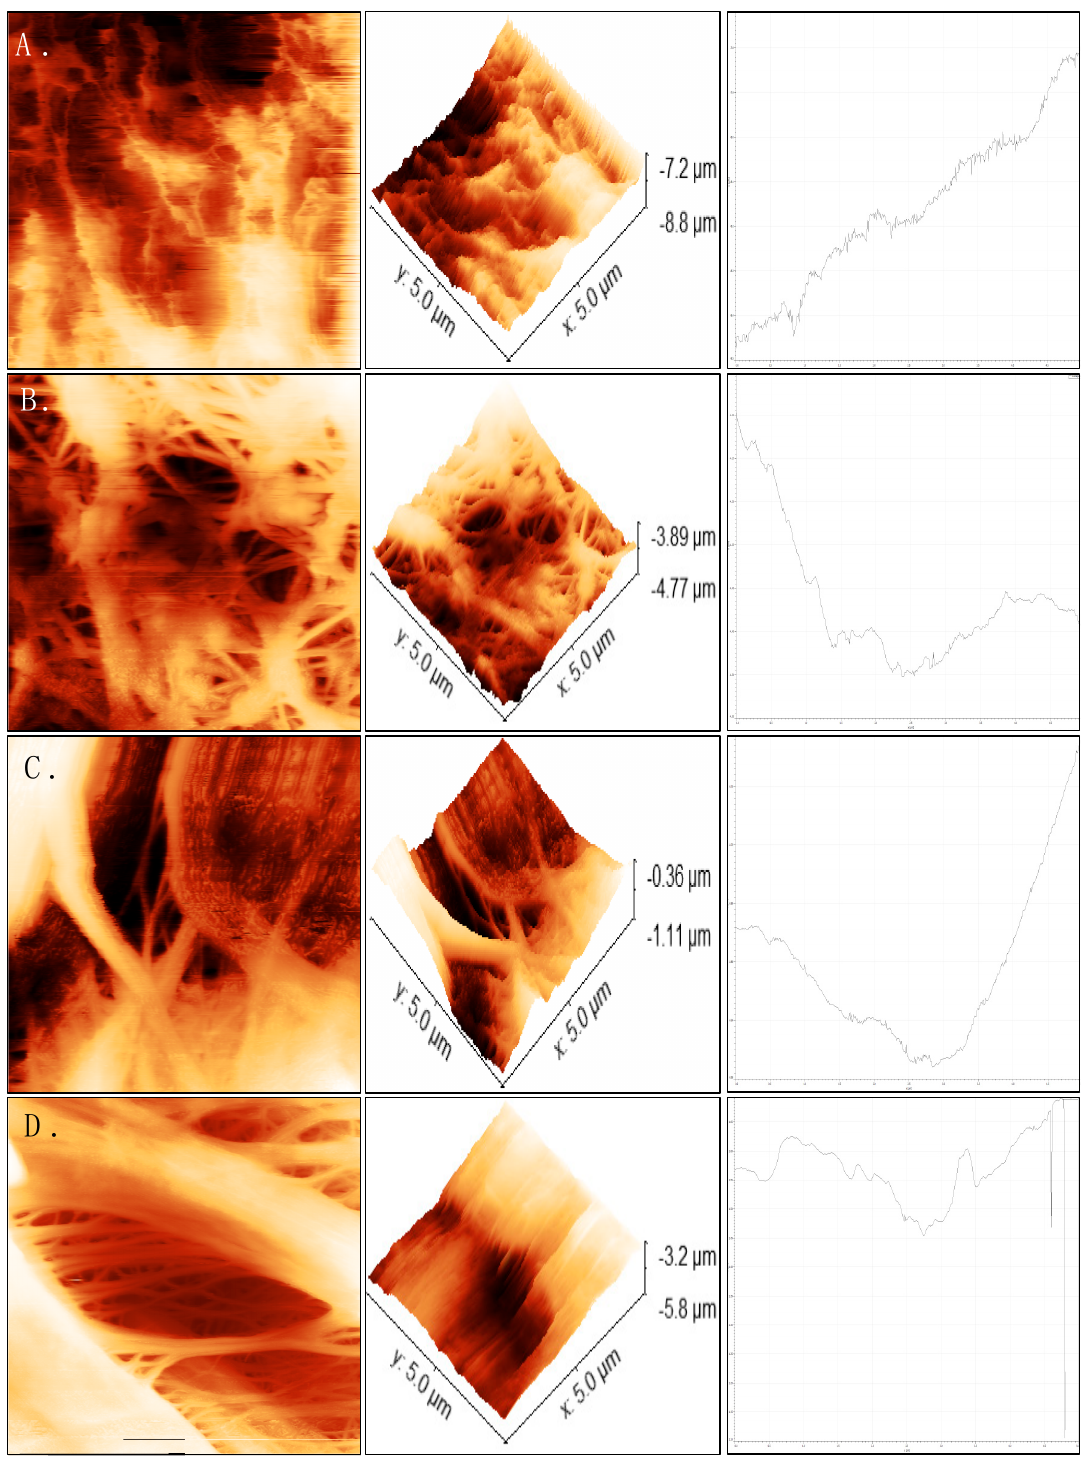
Figure 4. AFM analysis with flat maps, surface height maps and 2D profile for ( A ) PTFE with no RCWW exposure, ( B ) PTFE after 120 min RCWW exposure, ( C ) PP with no RCWW exposure and ( D ) PP after 15 min RCWW exposure.